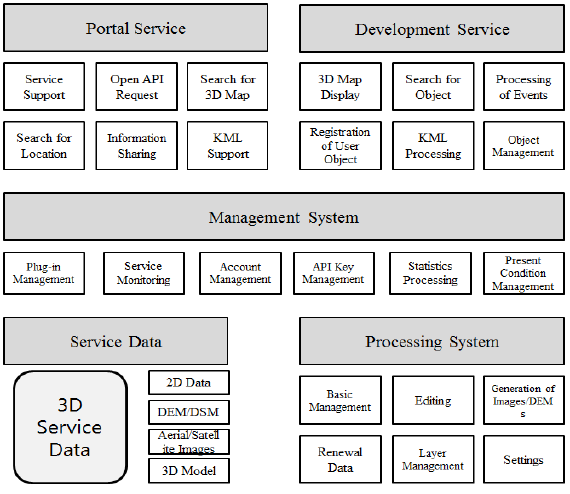
Figure 5. Framework of the Open Platform Service (V-world)